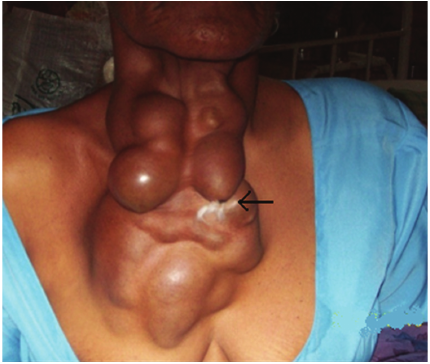
Figure 1: Preoperative photo multiple cysts in neck and chest with sinus (arrow).